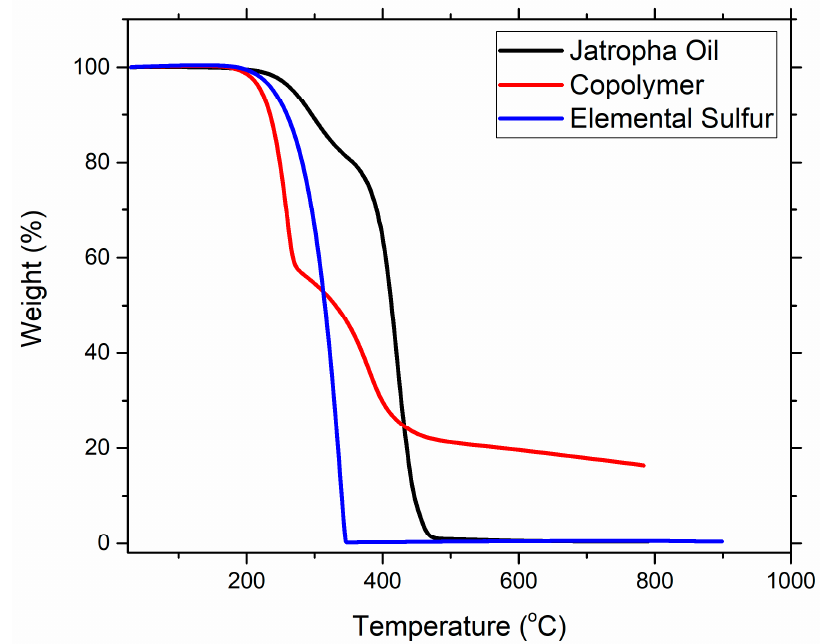
Figure 5. TGA thermogram of the optimized copolymer.